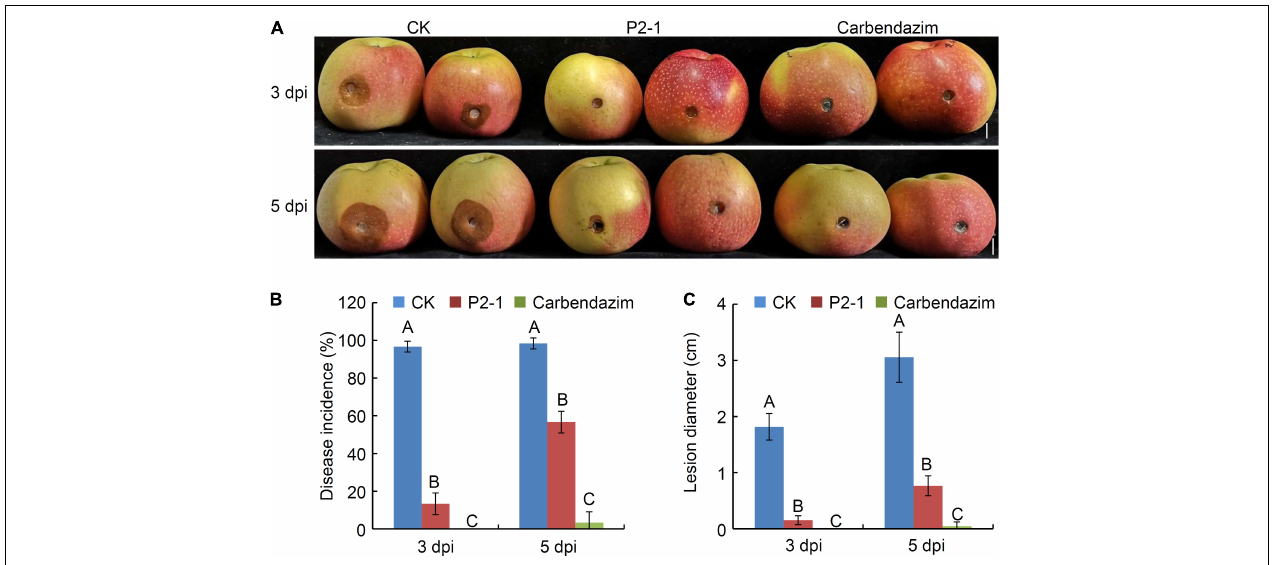
FIGURE 3 | Suppression of B. velezensis strain P2-1 cell suspension on apple ring rot caused by B. dothidea . (A) Strain P2-1 cell suspension antagonized apple ring rot. Treatment with sterile distilled water or carbendazim was used as the negative and positive control, respectively. Bar = 1 cm. (B) Statistical analysis of the disease incidence. (C) Statistical analysis of disease lesion diameter. Each data represents the mean ± SD of three replicates. Disease lesion length and disease incidence were measured at 3 and 5 days post inoculation (dpi), respectively. Letters above the bars indicate statistical significance and different letters indicate significant different means ( p < 0.01) based on Student’s t